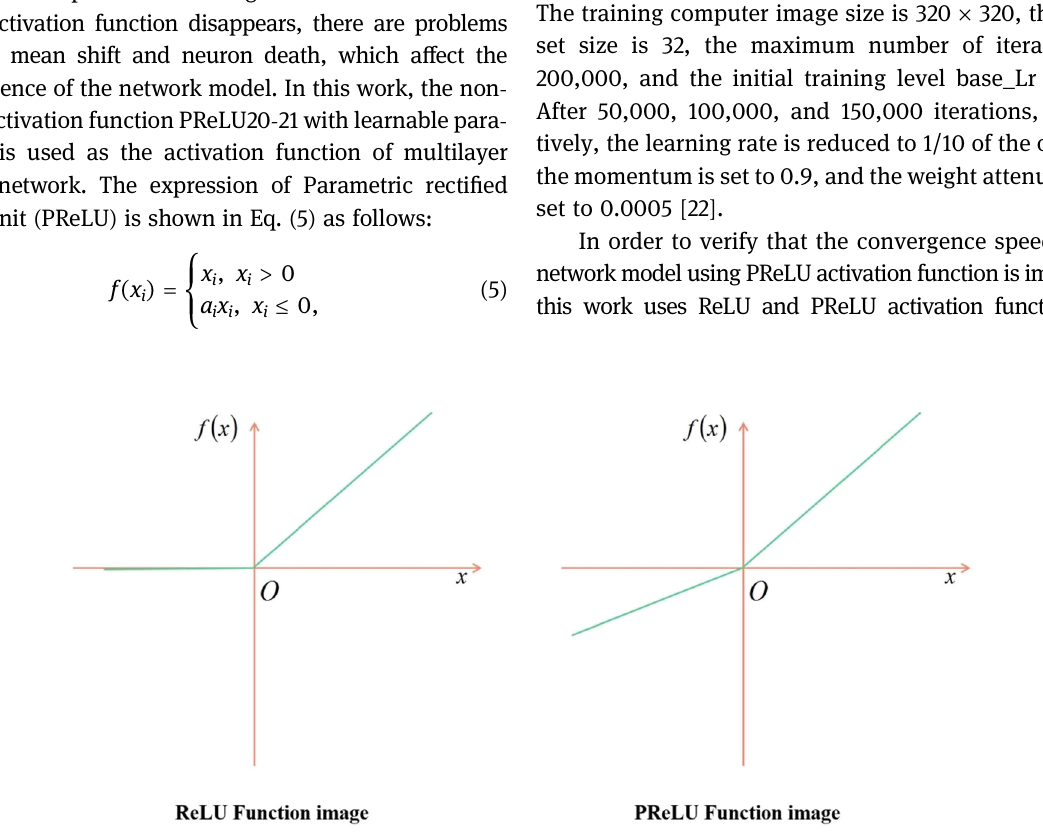
Figure 2: Images of ReLU function and PReLU